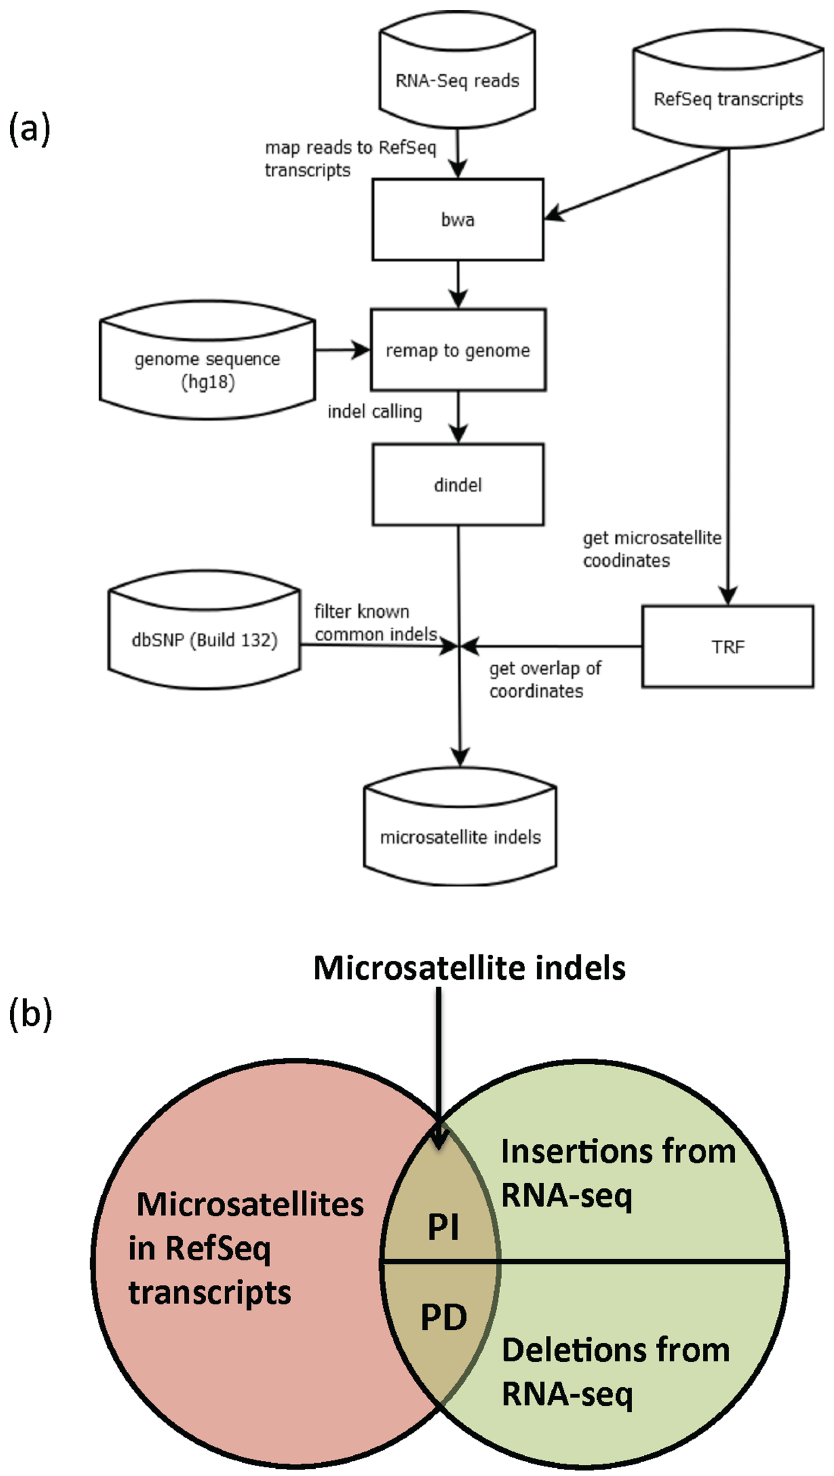
Figure 1. An outline of the study (a) MSI characterization pipeline used in this study (b) Definition of PI and PD. PI refers to the proportion of insertions in microsatellites over all insertions, and PD refers to the proportion of deletions in microsatellites over all deletions. significantly different between MSI and HapMap samples and sequences (p= 1e–5, Student’s t-test; Figure 3a ) when compared between MSS and HapMap samples. We observed a significant to HapMap samples, while the proportion remained similar in increase in the proportion of indels in MSI samples’ coding MSS samples (p= 0.15, Student’s t-test). Corresponding to this